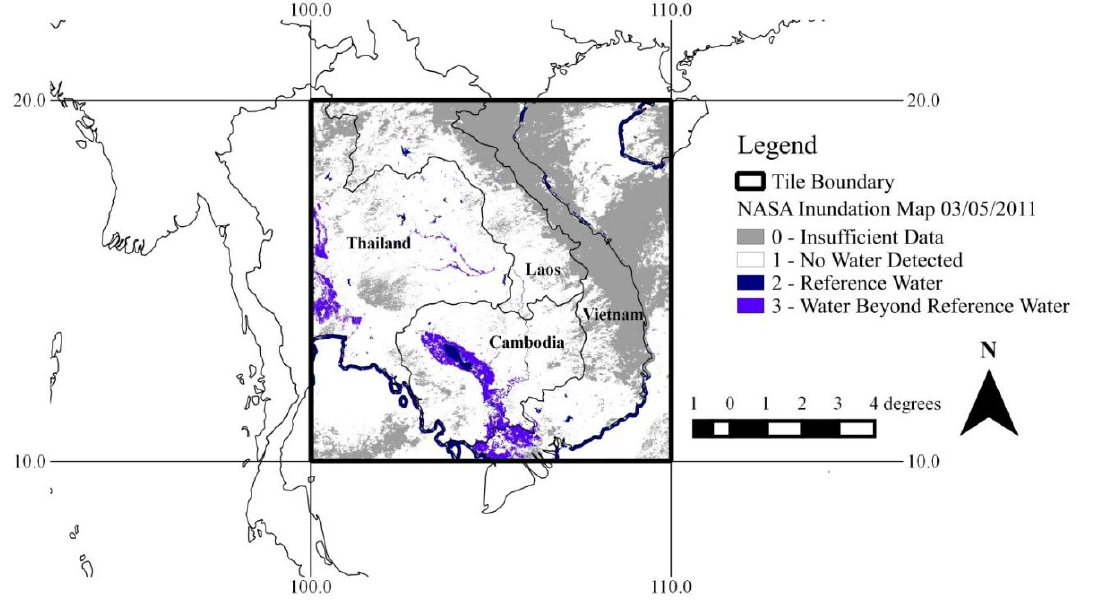
Figure 8. NASA Flood Map 10 × 10 degree tile over Southeast Asia with tile cell